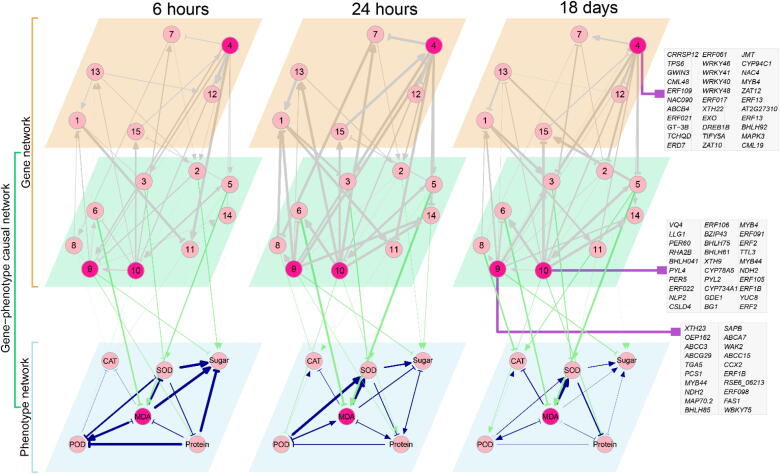
The transcriptional network of 15 modules and its link to the phenotypic network of six physiological traits through a causal network. Nodes are genes or traits indicated by circles (where dark circles denote the hubs of networks), and edges are gene regulation, activation or inhibition, indicated by arrowed line and T-shaped line, respectively. The thickness of lines are proportional to the strength of gene regulation. Hub modules 4, 9, and 10 are composed of many genes (whose names are shown in grey squares) with known biological functions. Some pairs of modules, like 4 and 9, are mutually regulated.